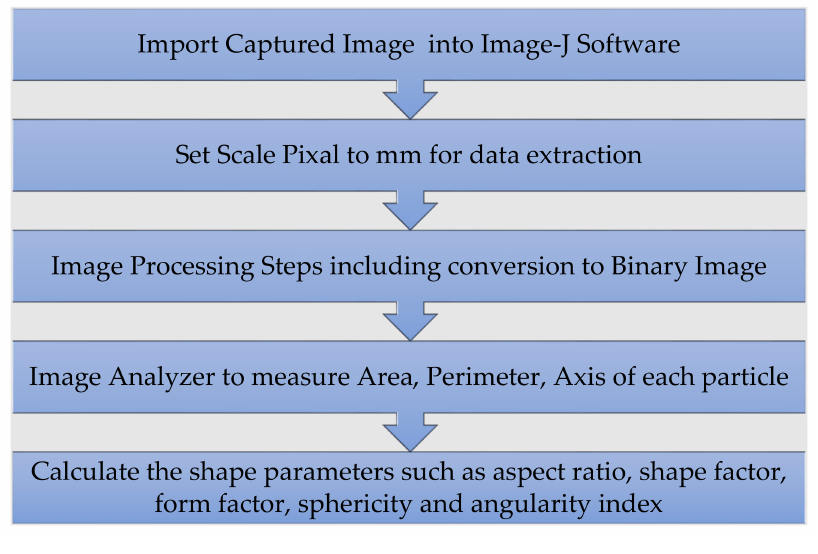
Figure 4. Image processing at the